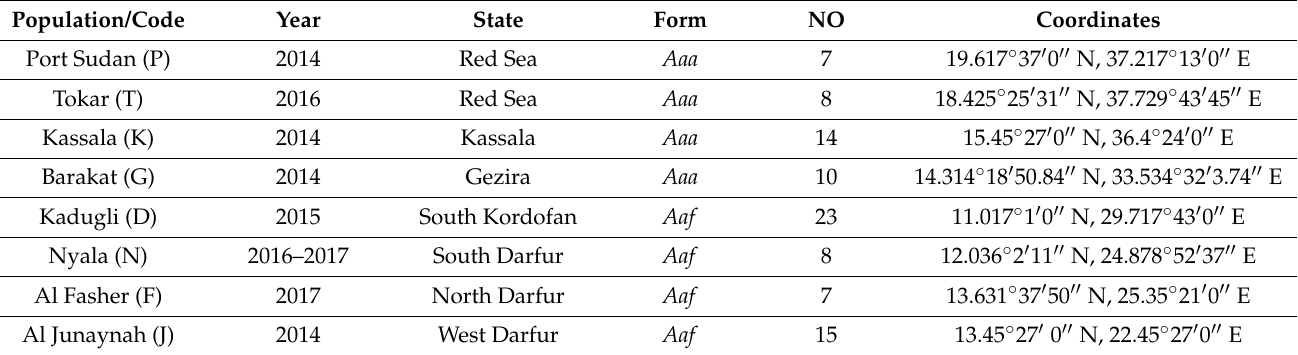
Table 1. Aedes aegypti populations and their